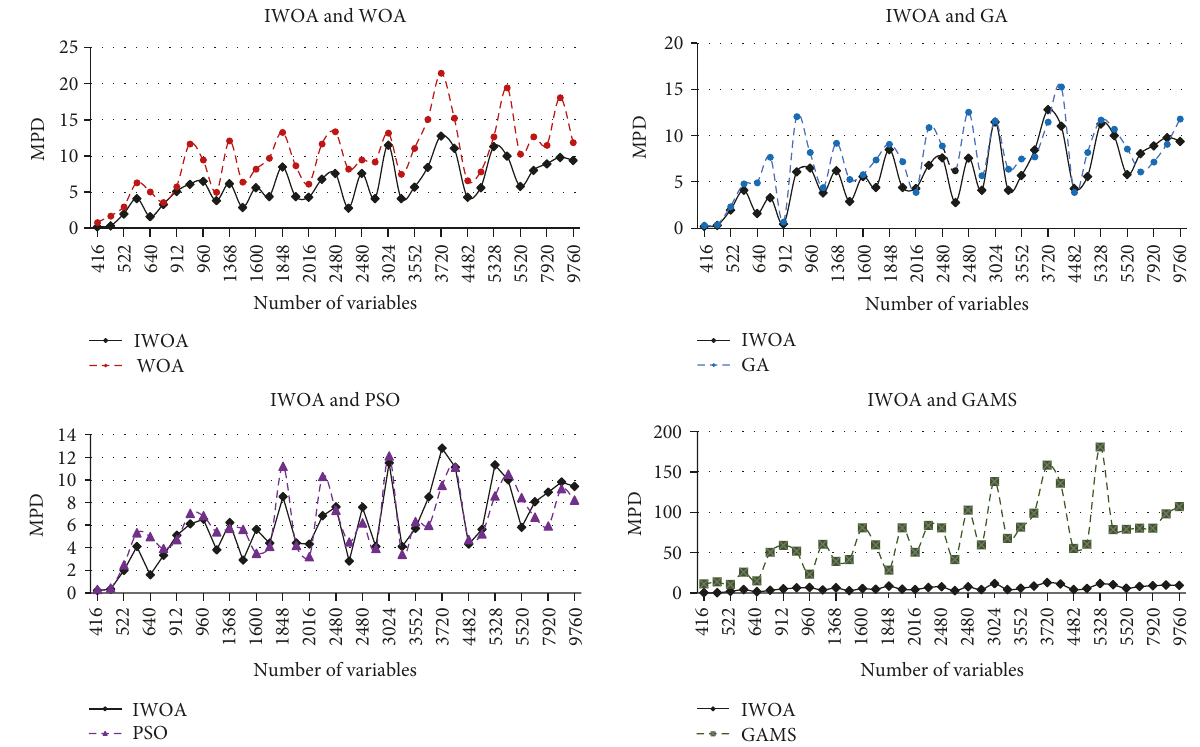
Figure 6: MPD comparison of IWOA with WOA, GA, PSO, and GAMS for medium-scale Table 6: Results of one-way ANOVA test for medium-scale instances. SS F -Value P -Value Test results